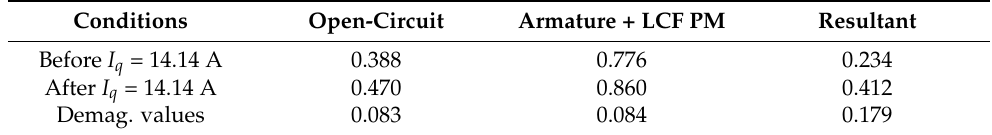
Table 1. Operating Flux Densities of LCF PMs during Demagnetization.